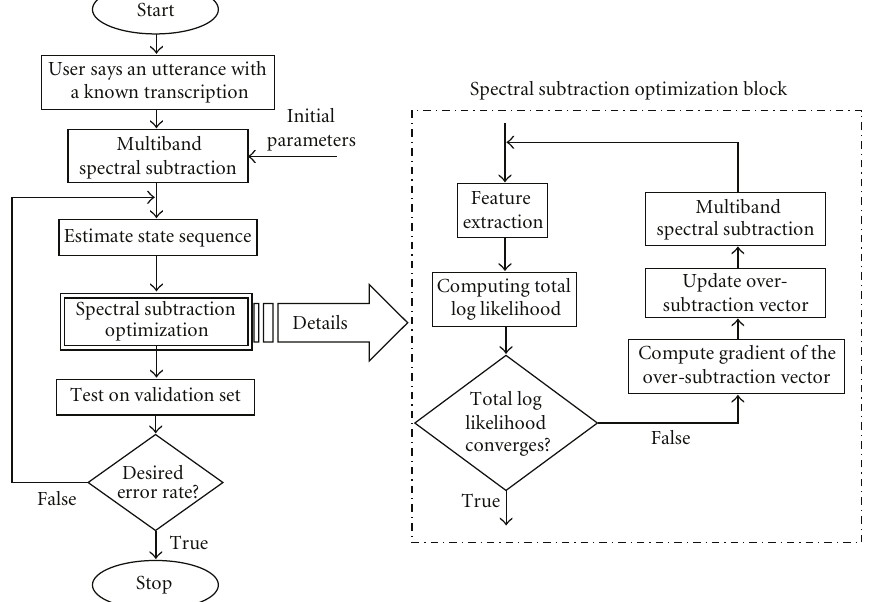
Figure 3: Flowchart of the proposed MLBSS